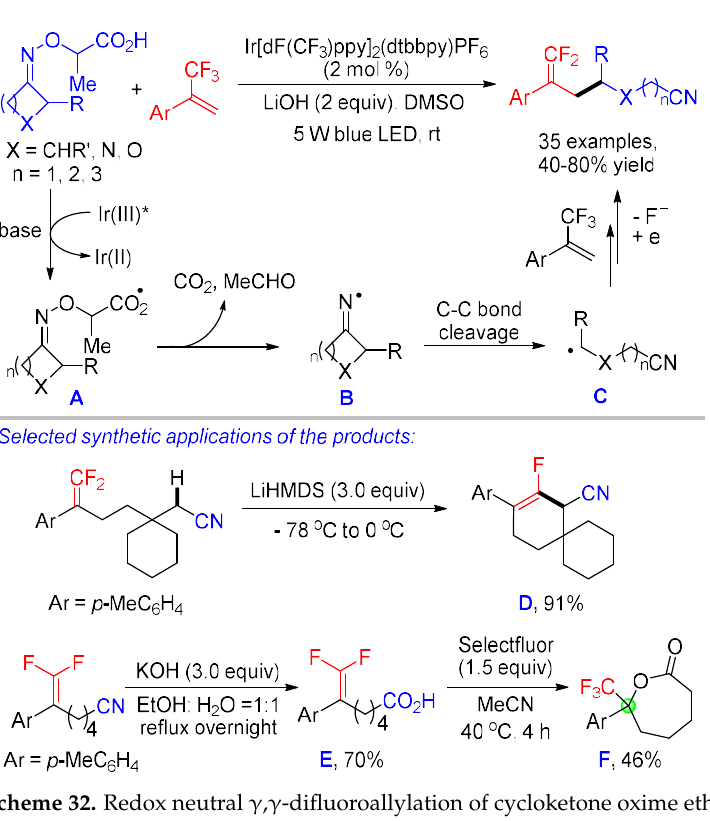
Scheme 33. Photocatalytic reductive coupling of alkyl iodides with CF 3 -alkenes: ( a ) XAT mediated by an α–aminoalkyl radical; ( b ) XAT mediated by Mn 2 (CO) 10